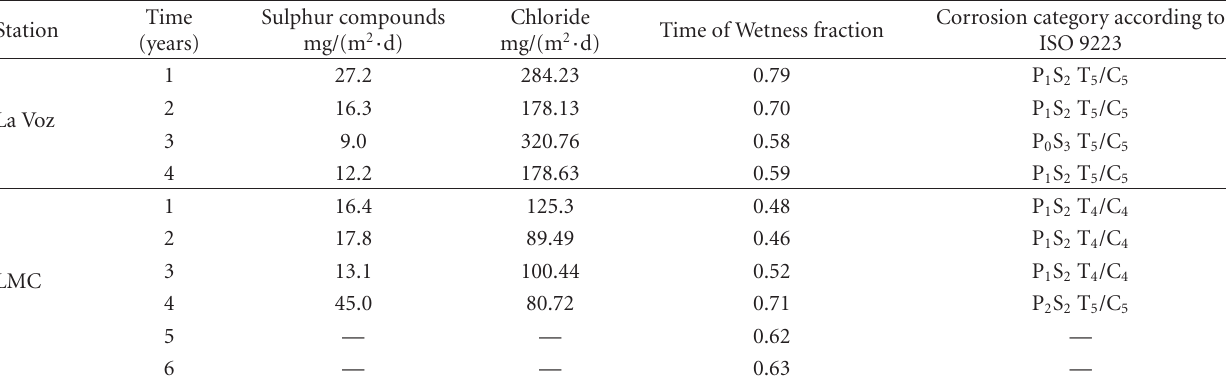
Table 3: Average levels of air chemical agents during four and six years of exposure in La Voz Station and LMC Stations, respectively.